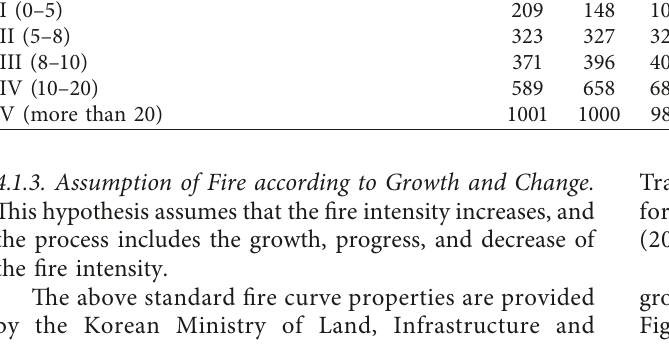
Table 2: Maximum surface temperature of steel bridges according to mobilization time criteria and vertical clearance (130MW). Unit: ° C. Mobilization time criteria for fire suppression